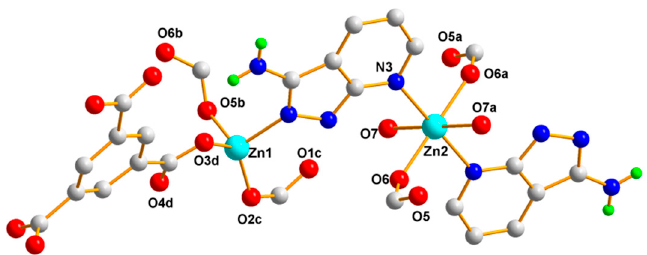
Figure 5. The coordination environment of the Zn(II) ions in Polymer 2. The hydrogen atoms have been omitted for clarity.